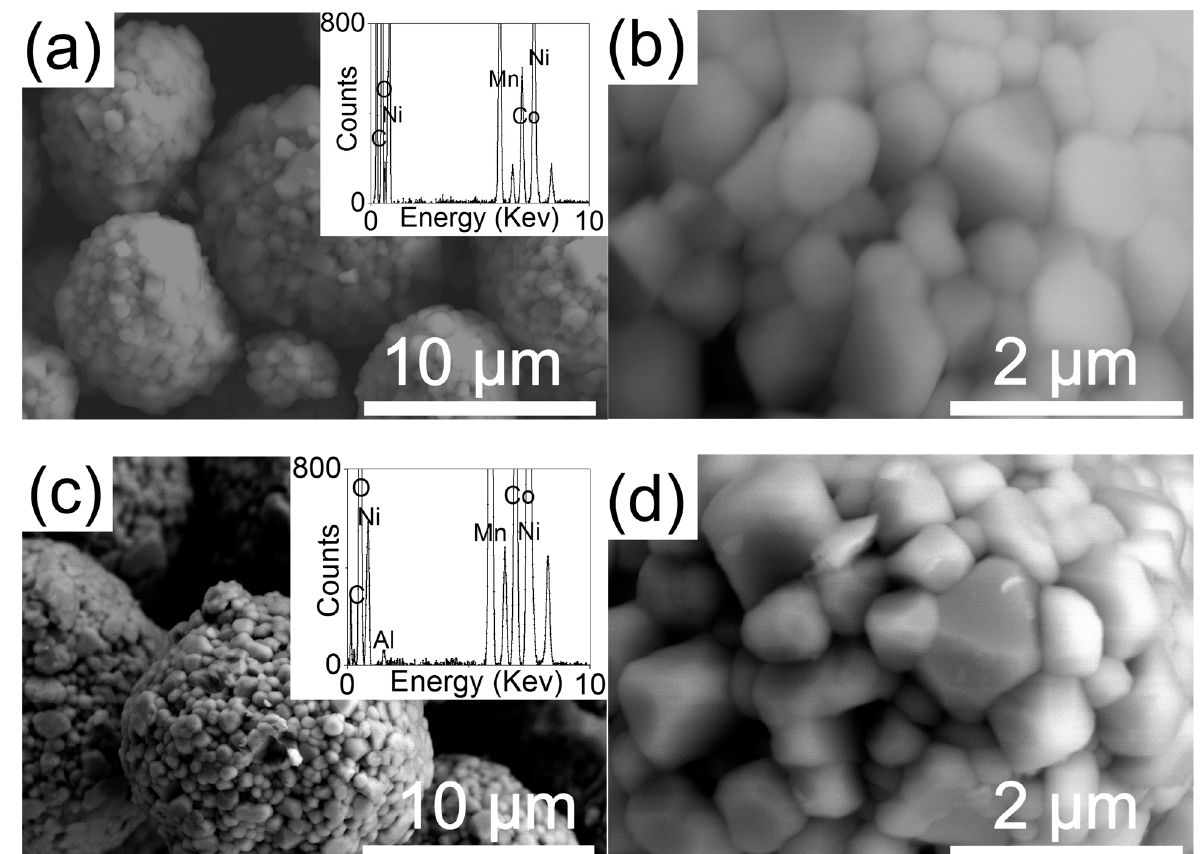
Figure 2. High and low magnification SEM/EDS of ( a , b ) pristine NCM523 and ( c , d ) NCM523 with Al 2 O 3 coating doping.